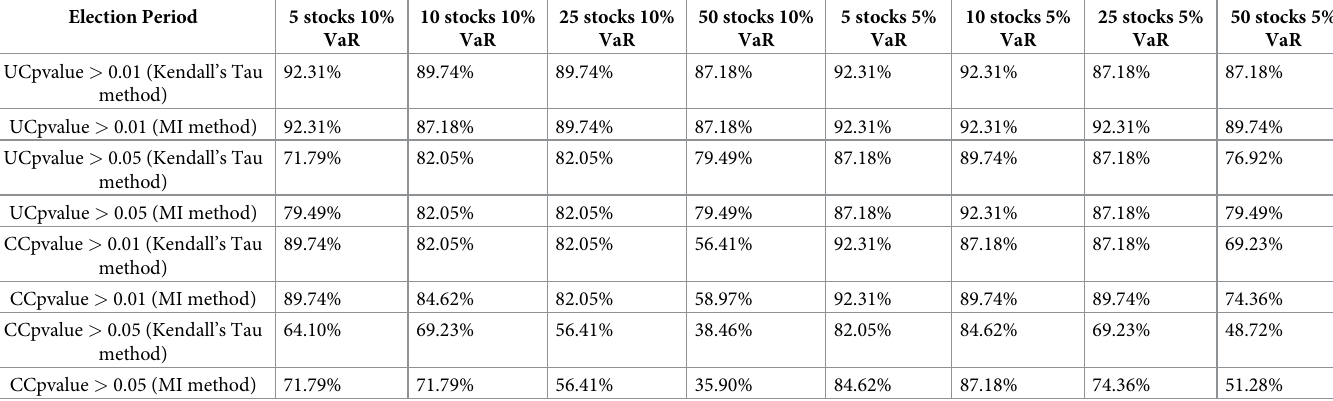
Table 2. Unconditional (UC) and conditional (CC) coverage tests at 1% and 5% level of significance: Election period. Election